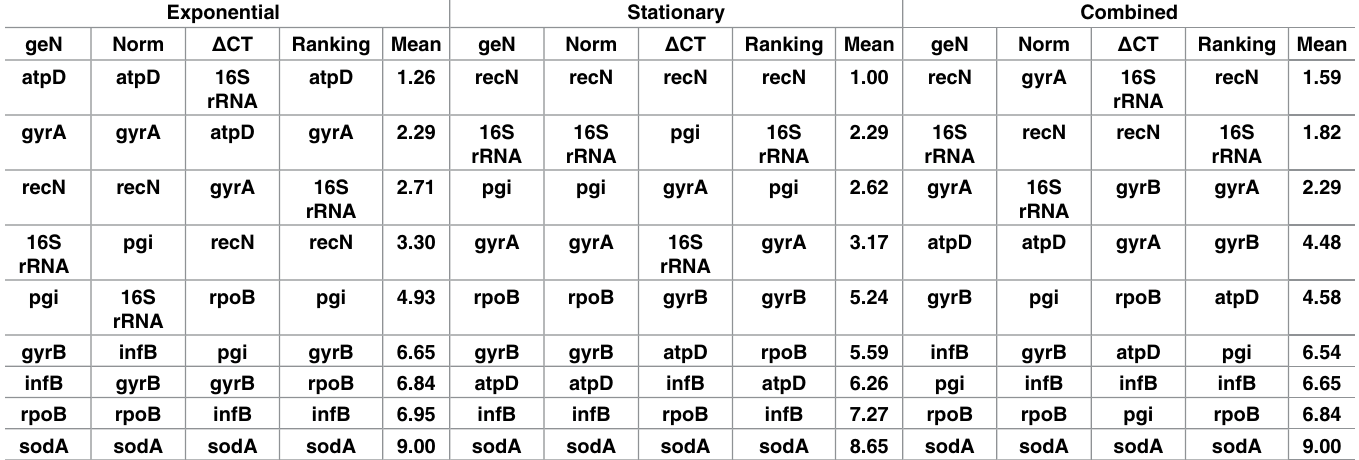
Table 10. Candidate reference genes ranked by different methods in serovarB.